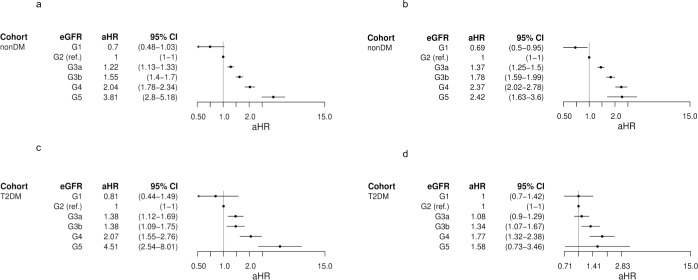
Adjusted hazard ratios for first major adverse cardiovascular event by time-dependent eGFR category in Cox models for type 2 and non-diabetes cohorts split by gender.a. Non-diabetes–female, b. Non-diabetes–male, c. Type 2 diabetes–female, d. Type 2 diabetes–male eGFR, estimated glomerular filtration rate. aHR, adjusted hazard ratio. CI, confidence interval. Non-DM, non-diabetes. T2DM, type 2 diabetes.